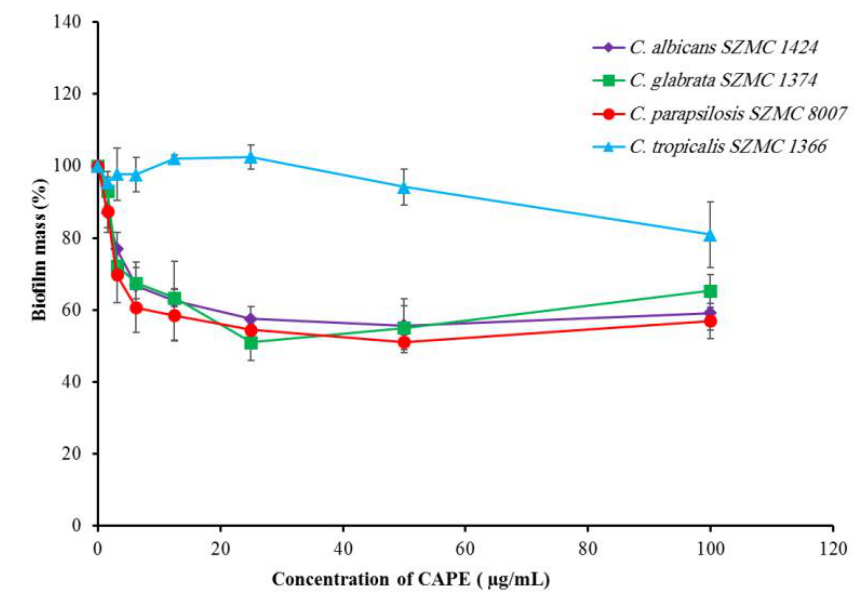
Figure 2. Effect of CAPE on mature biofilms of four Candida species. Data are shown as mean ± SD from three independent experiments.